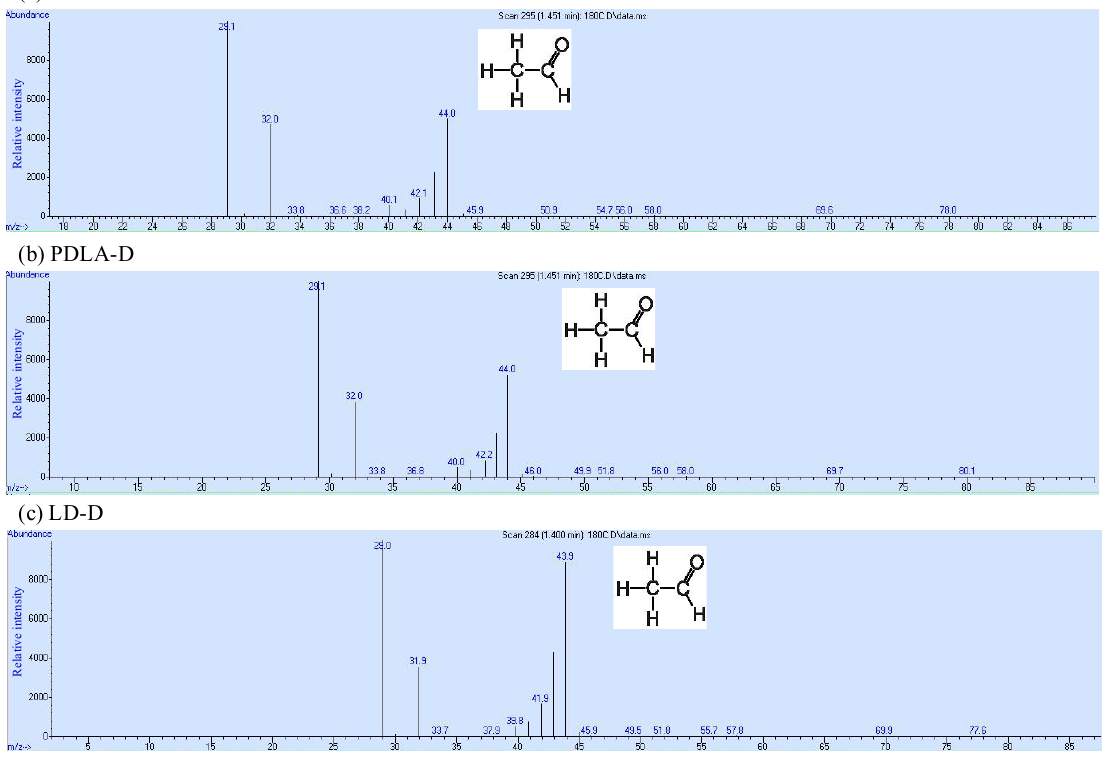
Figure 3. GC–MS characteristic fragmentation patterns of ( a ) PLLA-D, ( b ) PDLA-D, and ( c ) LD-D of peak 1.4 min.